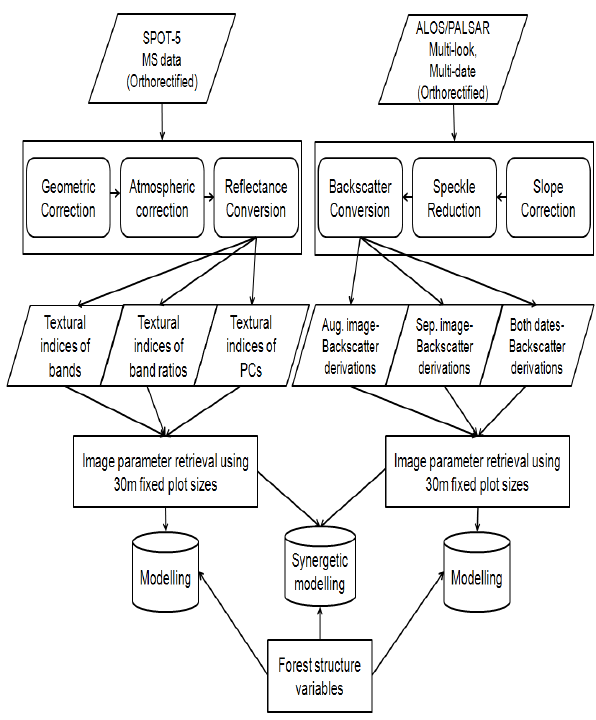
Figure 1. The methodology used in this